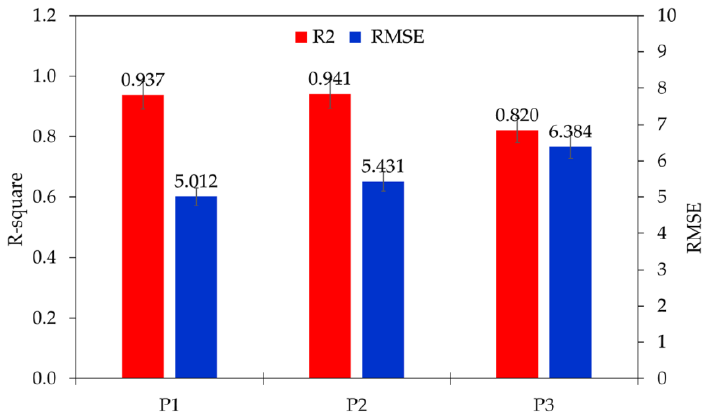
Figure 15. Average R 2 and RMSE for cross-well prediction.